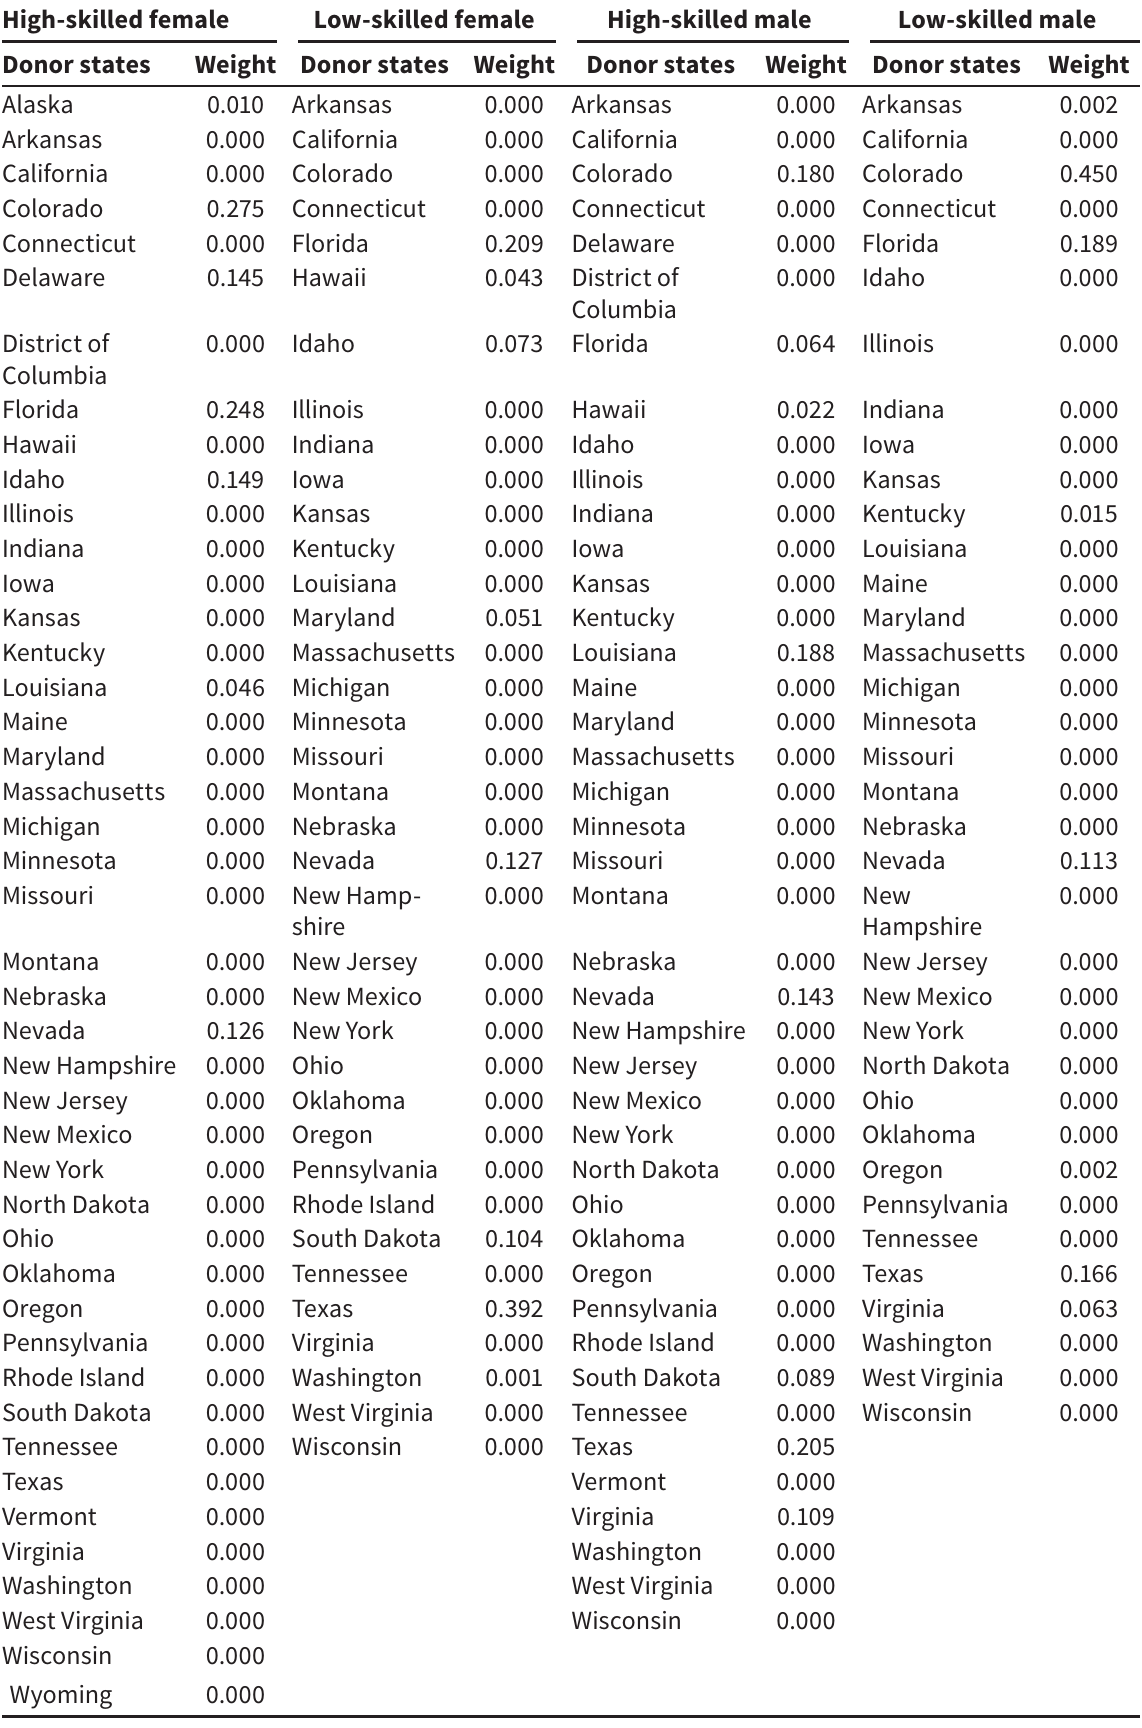
Weights used in construction of synthetic Arizona for time-use analysis in Table 4 High-skilled